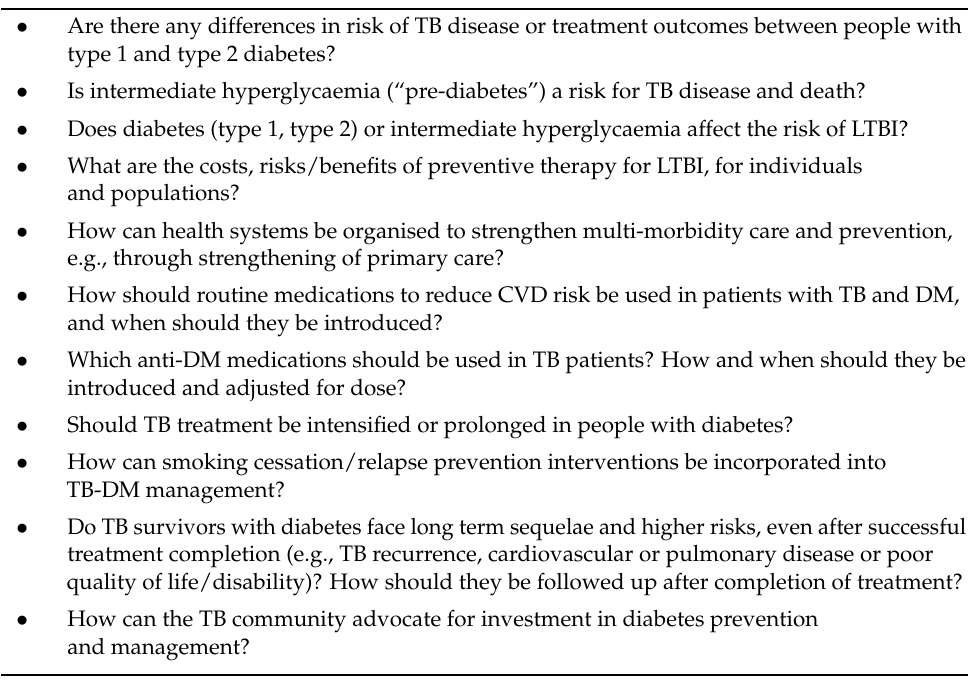
Table 4. Some Outstanding Clinical and Population Health Questions Related to Diabetes-Associated